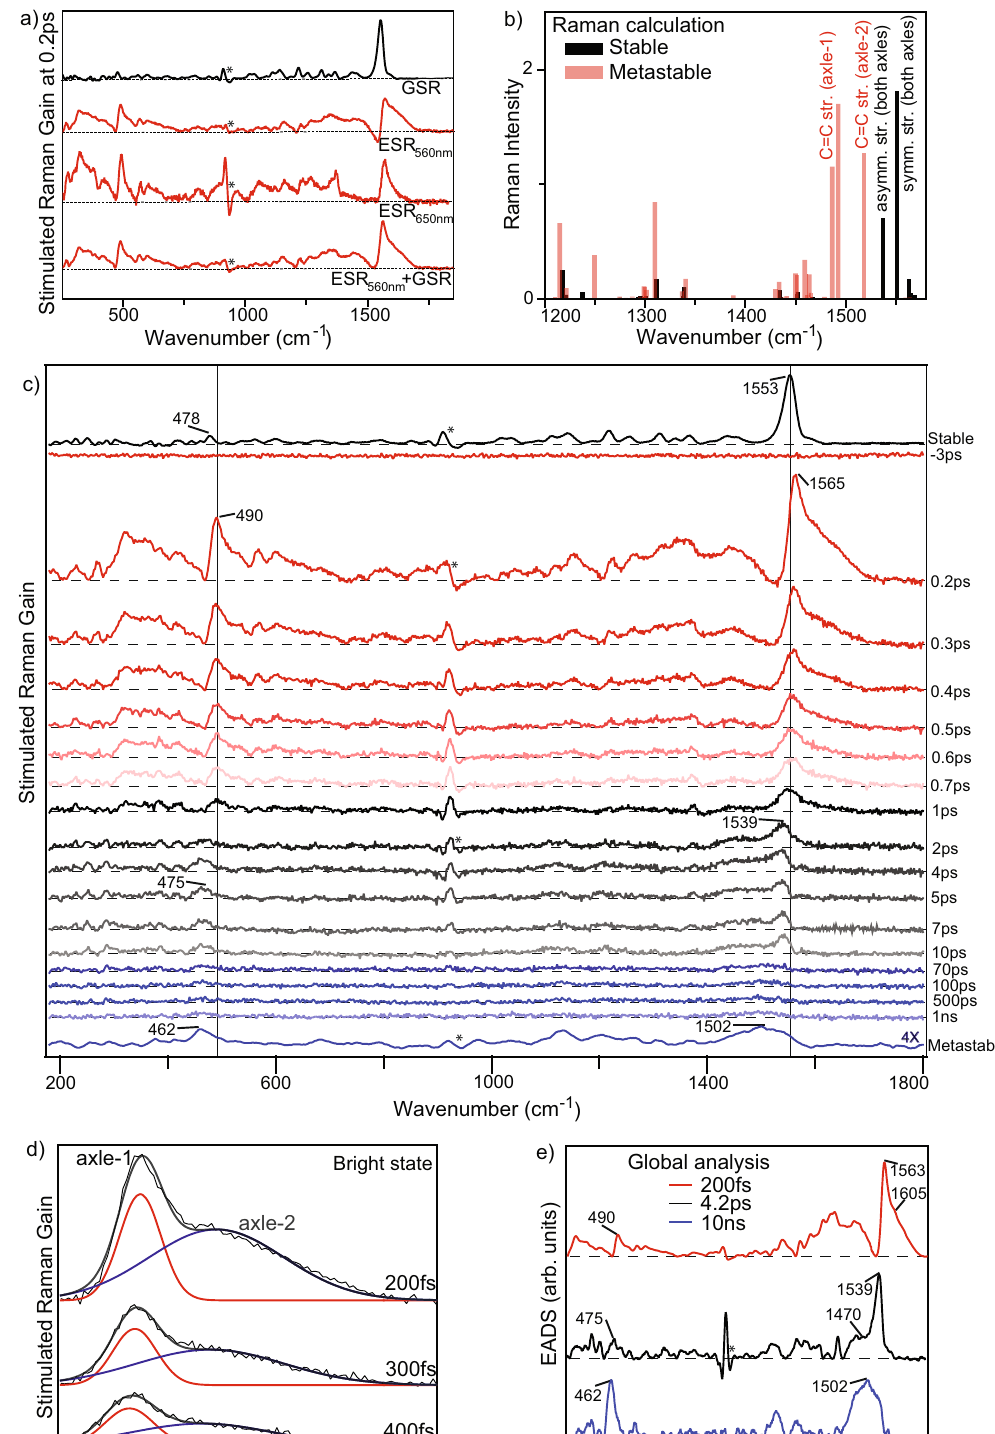
Fig. 3 | Characterization of 3GMph excited state structural dynamics by tran- sient Raman. a Measured ground state Raman (GSR, pump off) and excited state Raman(ESR, pump on)spectraof 3GMph, the latterat twodifferent Raman-pump wavelengths, 560nm and 650nm, both recorded 200fs after excitation in ACN. ThetrueESRspectrumat560nmhasbeenrecoveredfromthecomplexlineshape by bleach fi lling (i.e. ESR 560nm +GSR, See text). Pump pulse at 440nm; *indicates solvent artifact. b DFT calculated Raman spectra of the stable (black) and meta- stable (red) forms of the ground state. The computed frequencies were scaled by